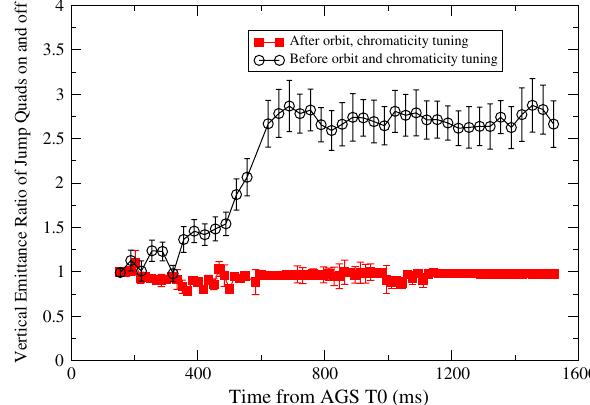
FIG. 5. The measured vertical emittance ratio of jump quads on and off on the AGS ramp. The measurements were done through repeated AGS cycles. The error bars are statistical errors only. The large error bars for the emittance growth case were due to fewer cycles for these measurements.